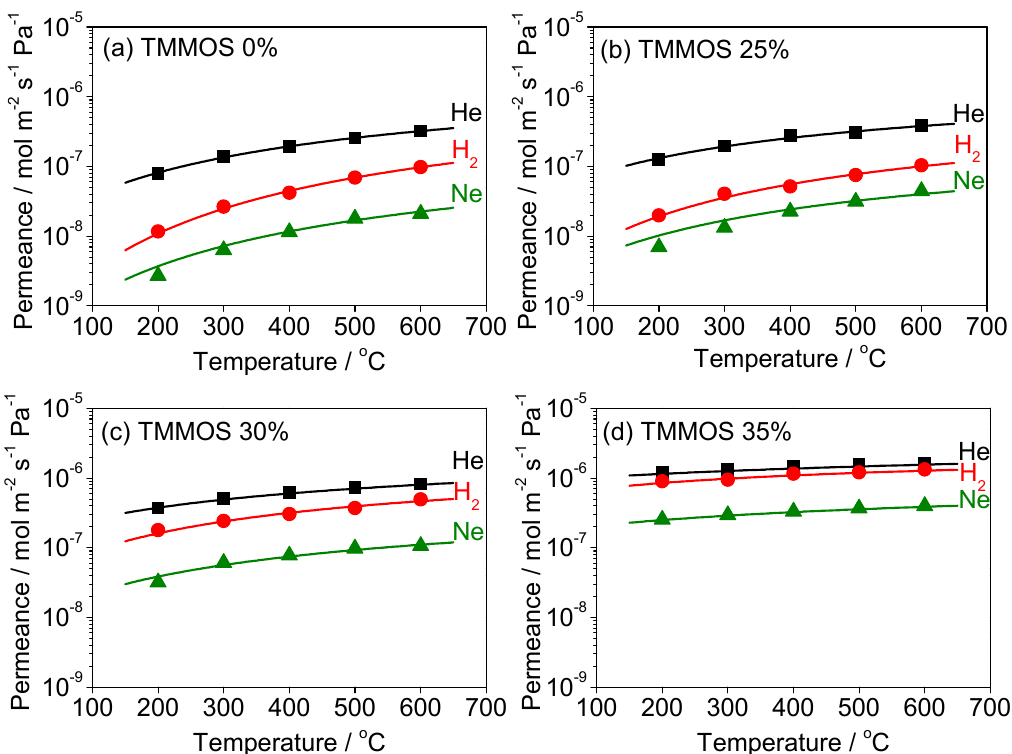
Figure 10. Fitting results by the solid-state diffusion model (permeance versus temperature, points are the experimental data and lines are the fitting results, black: He, red: H 2 , green: Ne, ( a ) TMMOS 0%,